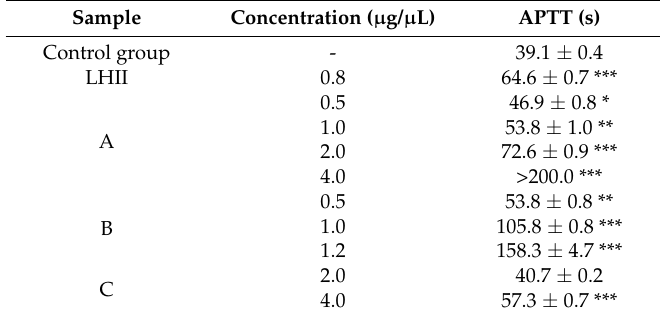
Table 2. Effects of compounds A, B, and C on plasma APTT. Values are expressed as mean of three measurements ± SD ( n =